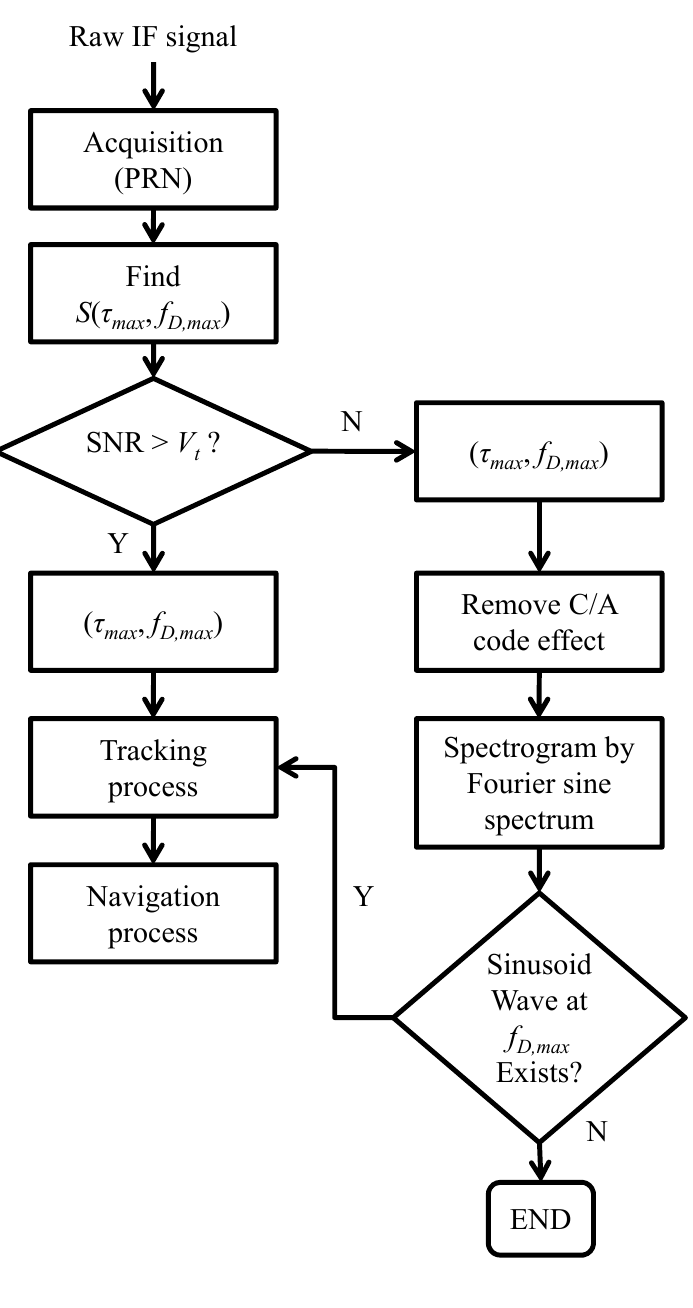
Figure 6. The block diagram of the signal existence verification (SEV) process for the low received power GPS signal